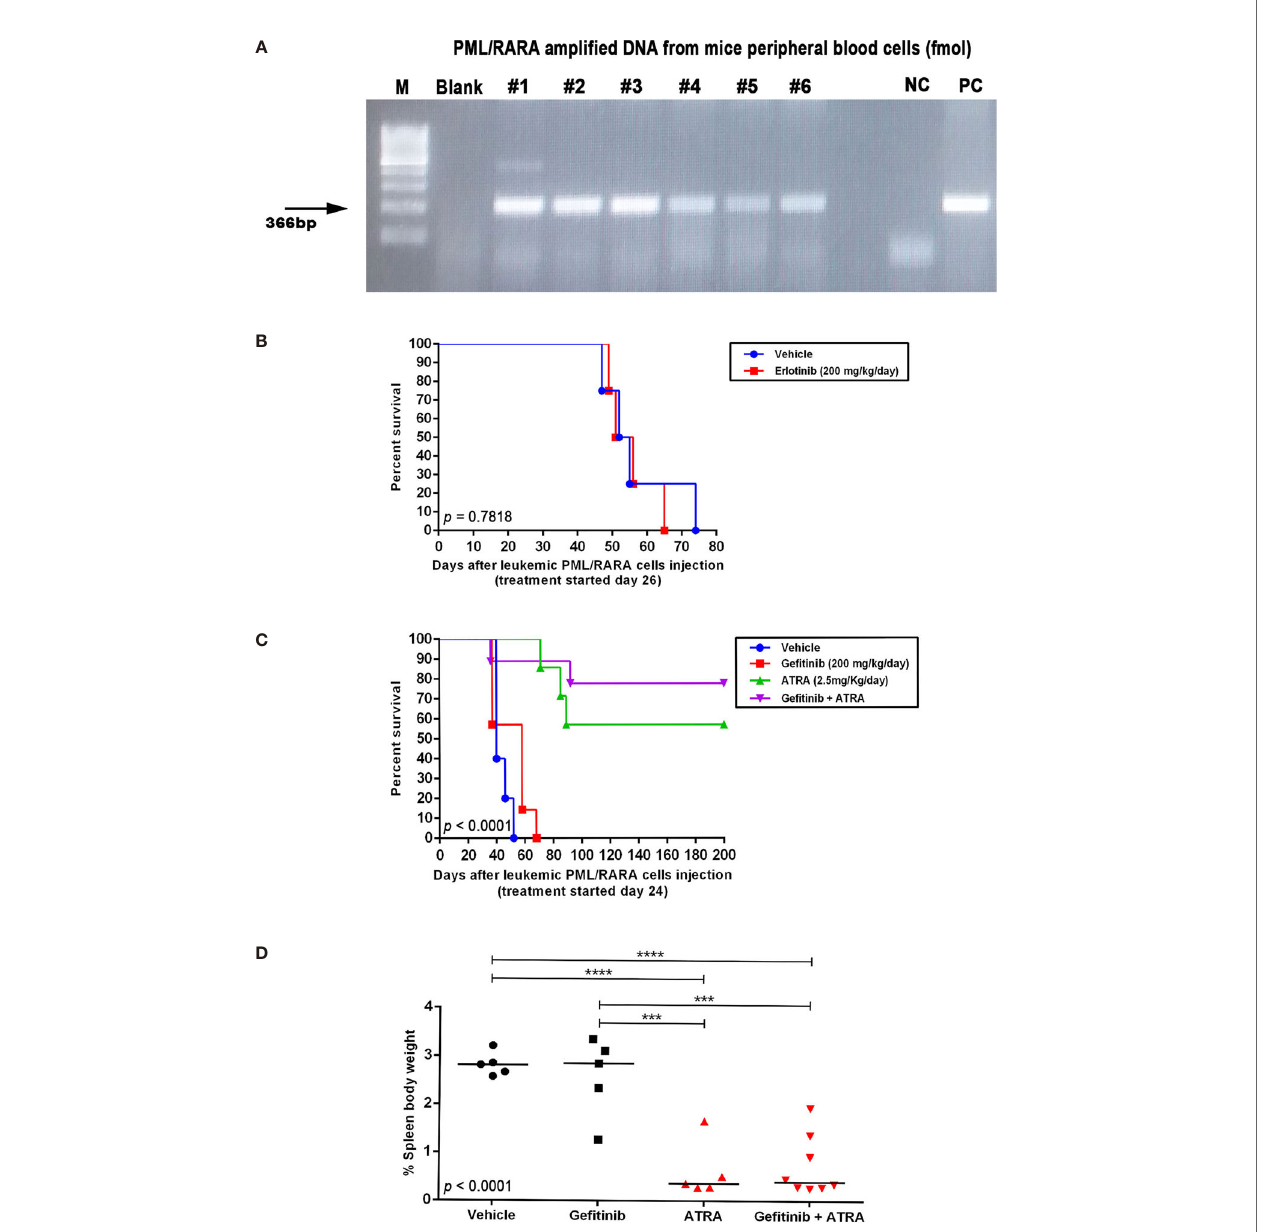
FIGURE 5 | In vivo effects of EGFR inhibitors alone or in combination with ATRA in an APL mouse model. (A) Expression of the PML – RARA fusion gene in peripheral blood of WT mice 3 weeks after transplantation of leukemic blasts from hCG-PML – RARA transgenic mice detected by conventional PCR. (B) Kaplan – Meier survival curves of mice treated with vehicle (DMSO; n=4) or erlotinib at 200 mg/kg/day (n=4). Survival (C) and spleen weight-to-body weight ratio (D) of mice treated with ge fi tinib [200 mg/kg/day; n=7 - (C) and n=5 - (D) ], ATRA [2.5 mg/kg/day; n=7 - (C) and n=5 - (D) ], ge fi tinib plus ATRA [n=9 - (C) and n=8 - (D) ], or vehicle [n=5 - (C, D) ]. Surviving mice at 200 days post transplantation were sacri fi ced. (***) p < 0.001, (****) p < 0.0001 (log-rank or Kruskal-Wallis test followed by Dunn ’ s post hoc